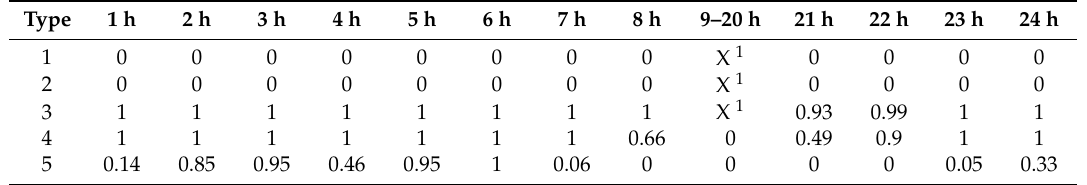
Table 7. The LLOAF states of different types of coal-fired units in the